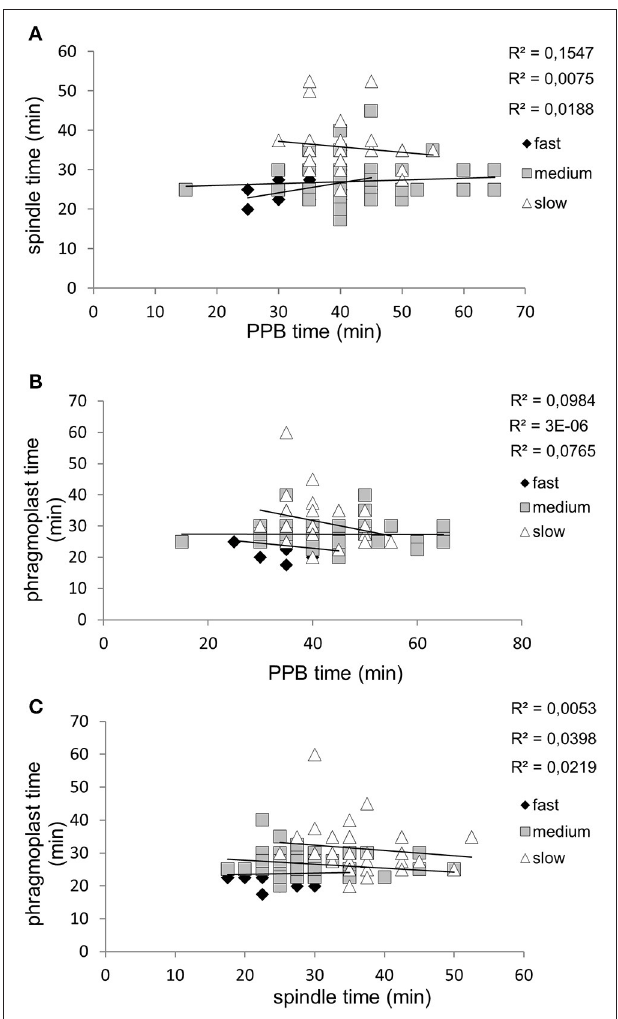
FIGURE 8 | Correlations between duration time of individual cell division stages in all measured dividing cells. (A) Correlations between duration time of the PPB stage and mitotic spindle stage in fast-growing ( (cid:7) ), medium-growing ( (cid:3) ), and slow-growing ( 1 ) roots. (B) Correlations between duration time of the PPB stage and phragmoplast stage in fast-growing ( (cid:7) ), medium-growing ( (cid:3) ) and slow-growing ( 1 ) roots. (C) Correlations between duration time of